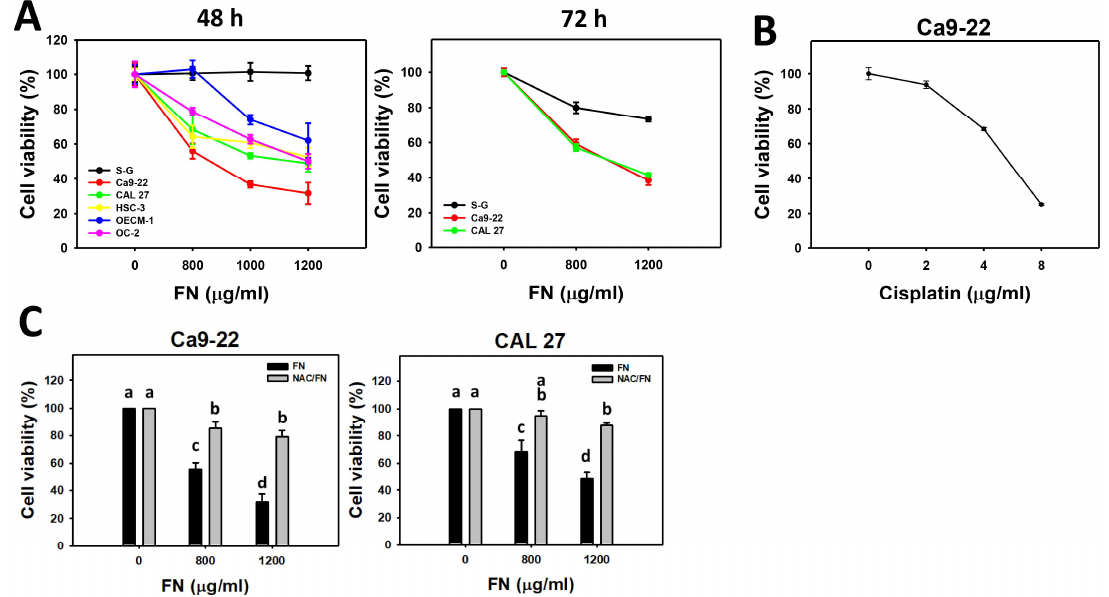
Figure 1. Fucoidan (FN) decreases the cell viability of oral cancer cells but not non-malignant cells. ( A ) MTS assay. After exposure to fucoidan (control, 800, 1000, and 1200 μg/mL) for 48 and 72 h, an MTS kit was chosen to determine the cell viability of oral cancer (Ca9-22, CAL 27, OECM-1, HSC-3, and OC-2) and non-malignant oral cells (S–G). ( B ) Cisplatin was a positive control for oral cancer cells (Ca9-22) following 24 h treatment. ( C ) The effect of oxidative stress on the cell viability of oral cancer cells following fucoidan treatment. After NAC (10 mM, 1 h) preincubation or not, cells were post-treated with control and fucoidan (0, 800, and 1200 μg/mL) with NAC co-treatment (10 mM) for 48 h. NAC/fucoidan (NAC/FN) represents pretreatment with NAC and post-treatment with FN. Data = mean ± SD ( n = 3 experiments). Data of the same cells with non-overlapping letters reveal significant differences ( p < 0.05). In the example of Figure 1B (Ca9-22 cells), FN at 0, 800, and 1200 μg/mL labeled with “a, c, and d” has significant results because the letters do not overlap. FN and NAC/FN of Ca9-22 cells at 800 or 1200 μg/mL labeled with “c and b” or “d and b” have significant results.